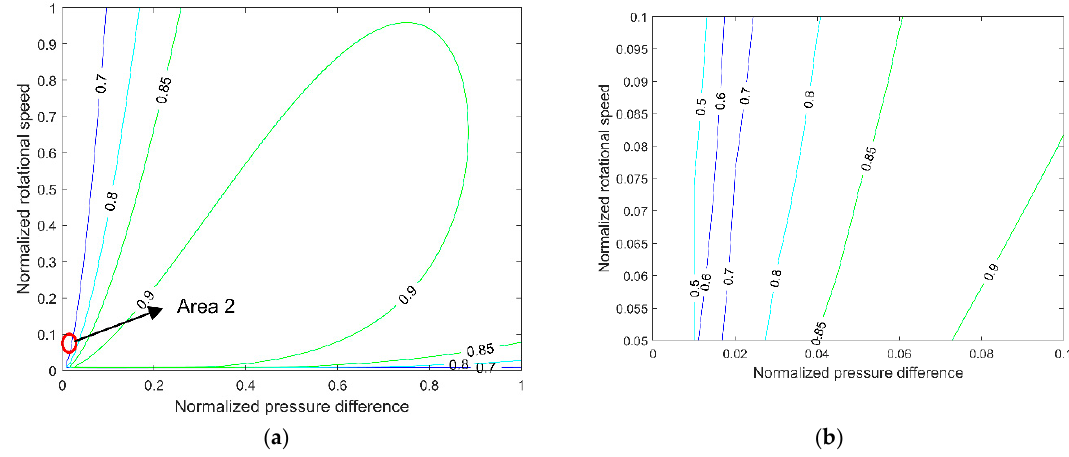
Figure 10. Efficiency contours of the PM as a function of the normalized pressure difference and rotational speed in motoring mode: ( a ) the whole view and ( b ) enlarged view of area 2.